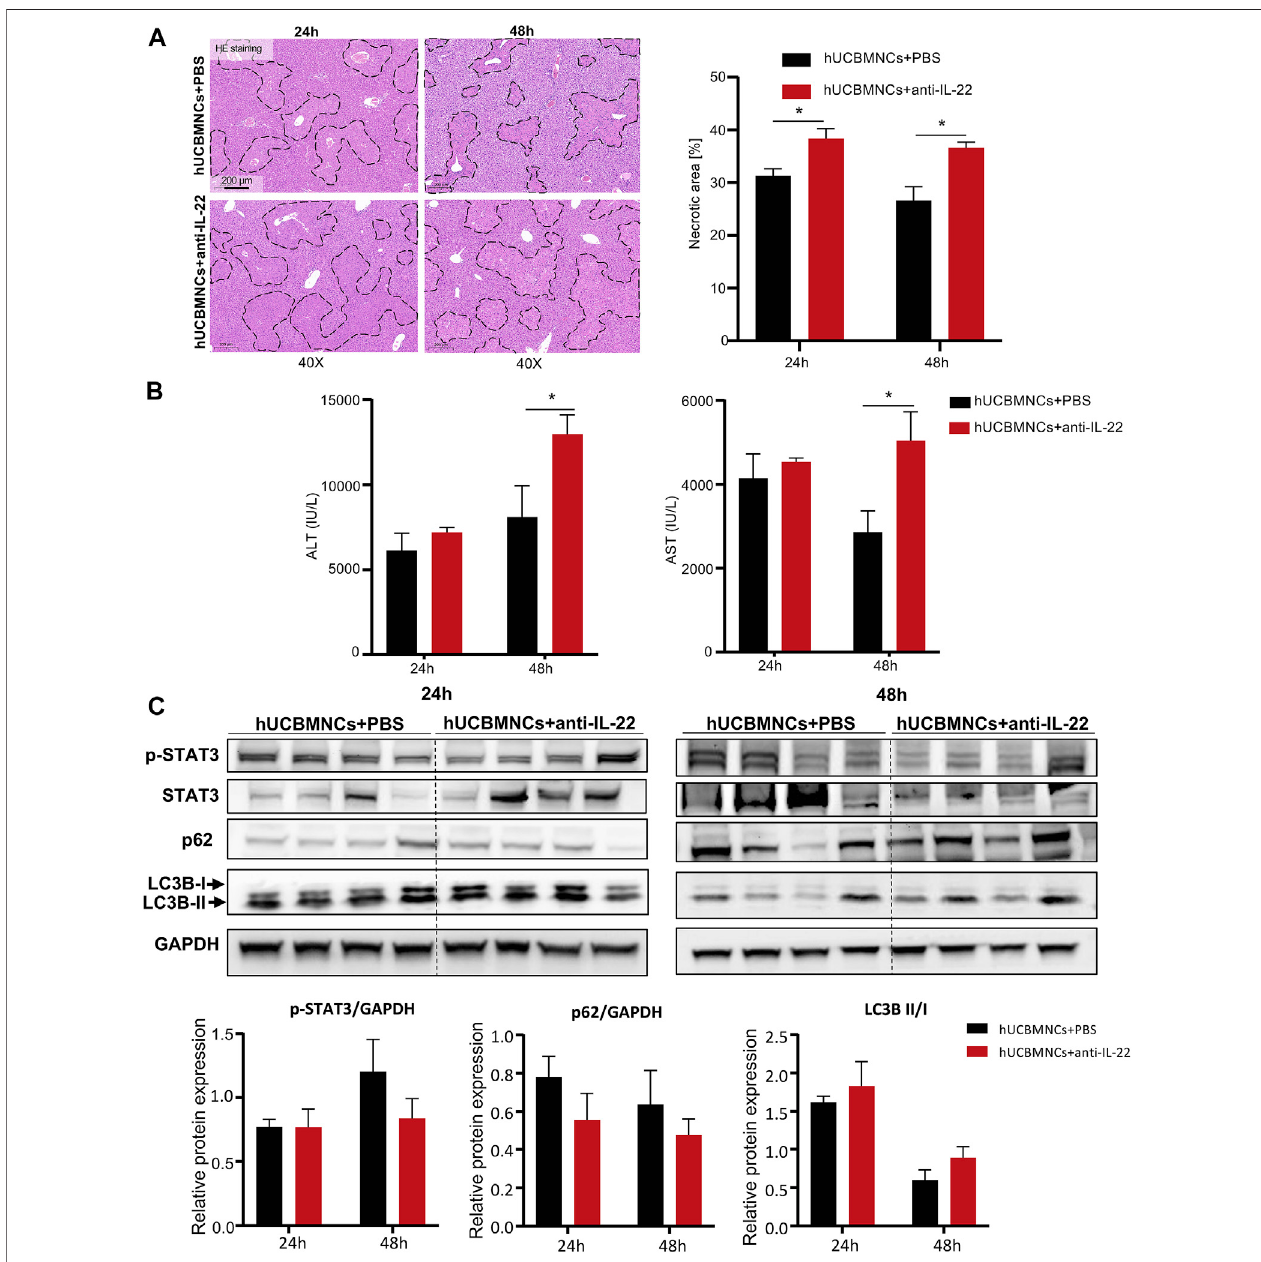
FIGURE 6 | Blocking IL-22 impaired the therapeutic effects of hUCBMNCs. (A) . H&E staining (×40) and necrotic areas percentage of mice liver at 24 h, 48 h post CCl 4 injection in the anti-IL-22 group and the control group (4 mice each group). (B) Serum ALT and AST levels of mice at 24 h, 48 h post CCl 4 injection in the anti-IL- 22 group and the control group (4 mice each group). (C) Expression of p-STAT3, p62, LC3B, and GAPDH of mice liver at 24 h, 48 h post CCl 4 injection in the anti-IL- 22 group and the control group (4 mice each group, experiments were repeated for 3 times). The bars represent mean ± SEM.